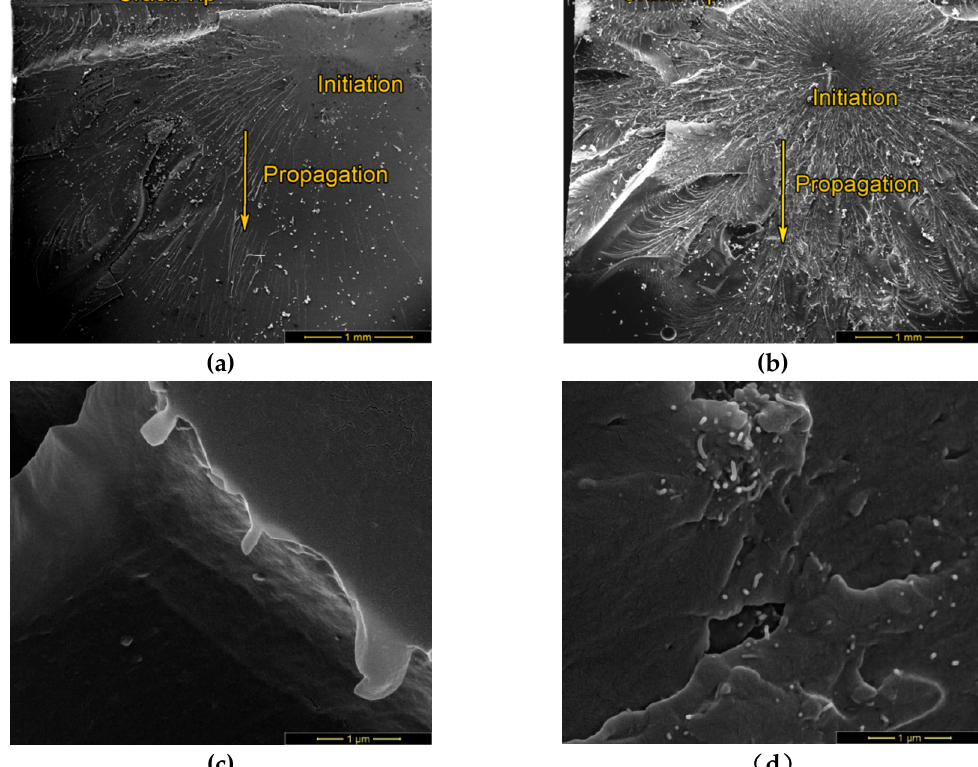
Figure 5. Micrographs from neat epoxy and CNT/epoxy. ( a ) Neat epoxy: Crack initiation started at the edge of the crack tip. ( b ) CNT/epoxy: Crack initiation started 0,5 mm away from the edge. ( c ) Neat epoxy: higher magnification reveals smooth surface. ( d ) CNT/epoxy: higher magnification shows plastic deformation at carbon nanotube agglomerates.